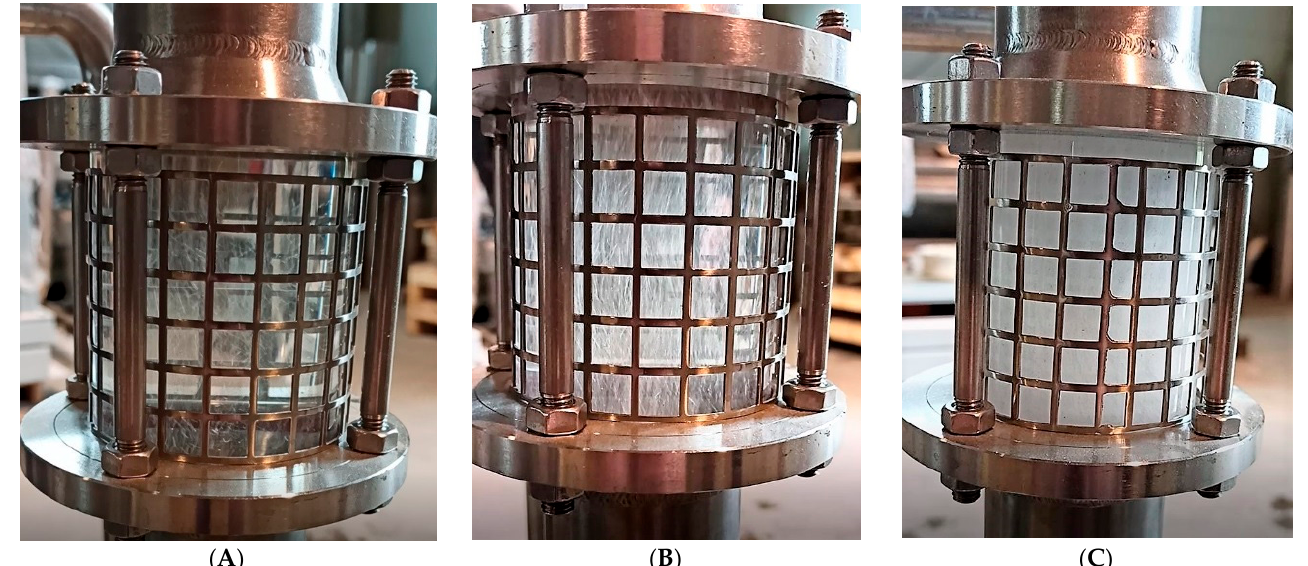
Figure 10. Results of the pump station tests. Working points p 2 = f( 𝑄(cid:4662) ) show the degree of dispersion in areas A, B, and C.